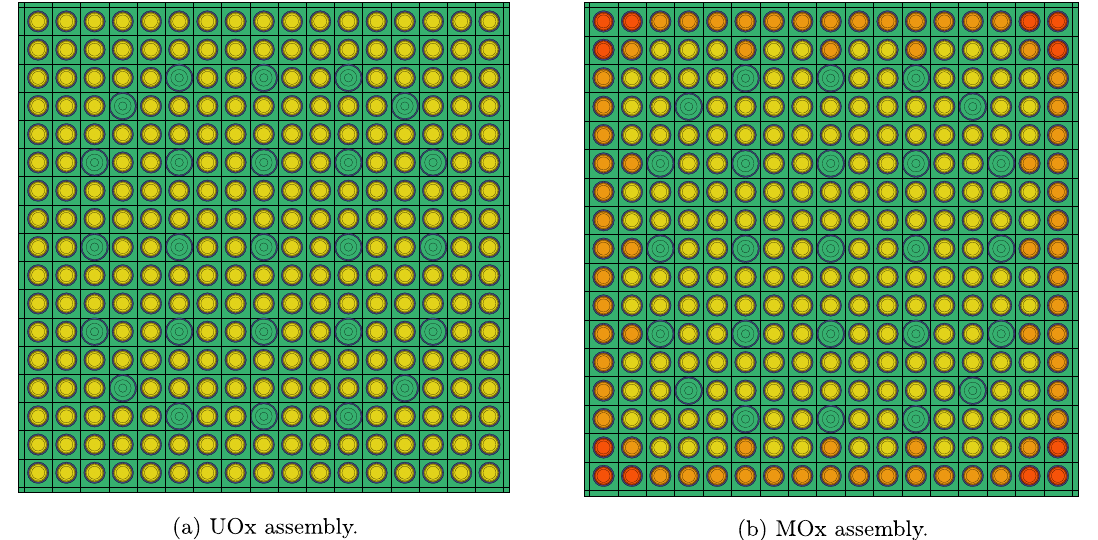
Fig. 1. UOx (a) and MOx (b) assembly geometries. Materials are identified as follows: moderator in green and fuel clad in purple. For the UOx assembly, fuel pellets are in yellow. For the MOx assembly, yellow, orange and red fuel pellets are characterized by high (9.77% HM ), medium (6.49% HM ) and low (3.66% HM ) Pu